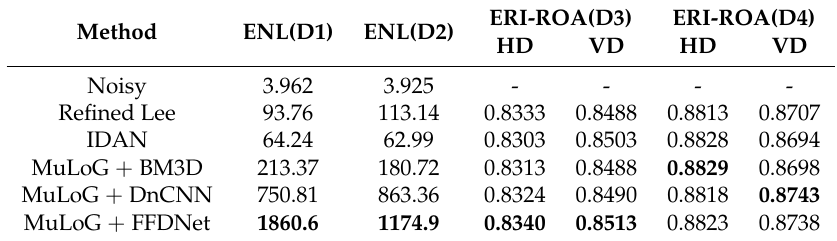
Table 6. The quantitative comparison of different methods for simulated PolSAR image with L = 4.